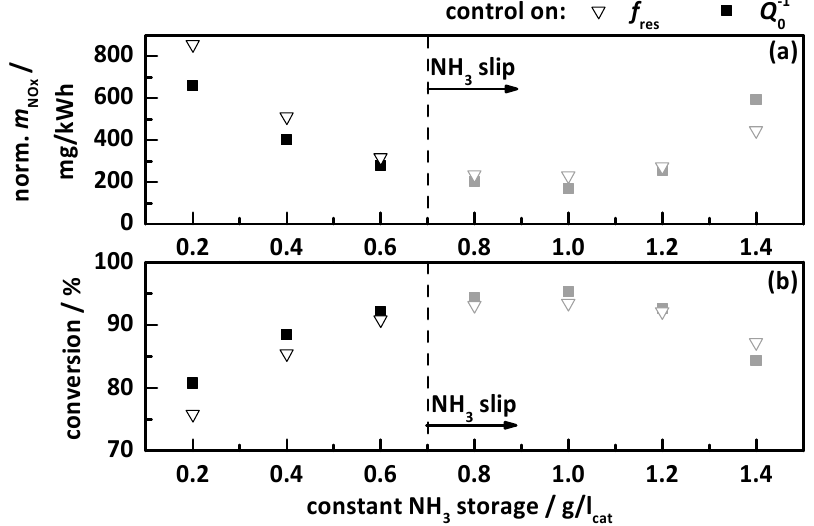
Figure 11. Results of the transient study for the control on a constant NH 3 storage by f res (hollow triangles) and Q 0 − 1 (filled squares), with ( a ) the apparent emitted and normalized NO x mass in mg/kWh as determined by the downstream NO x sensor, and ( b ) the resulting apparent NO x conversion within the test cycle. The storage curves right to the dashed line (grey marked) caused NH 3 slip.